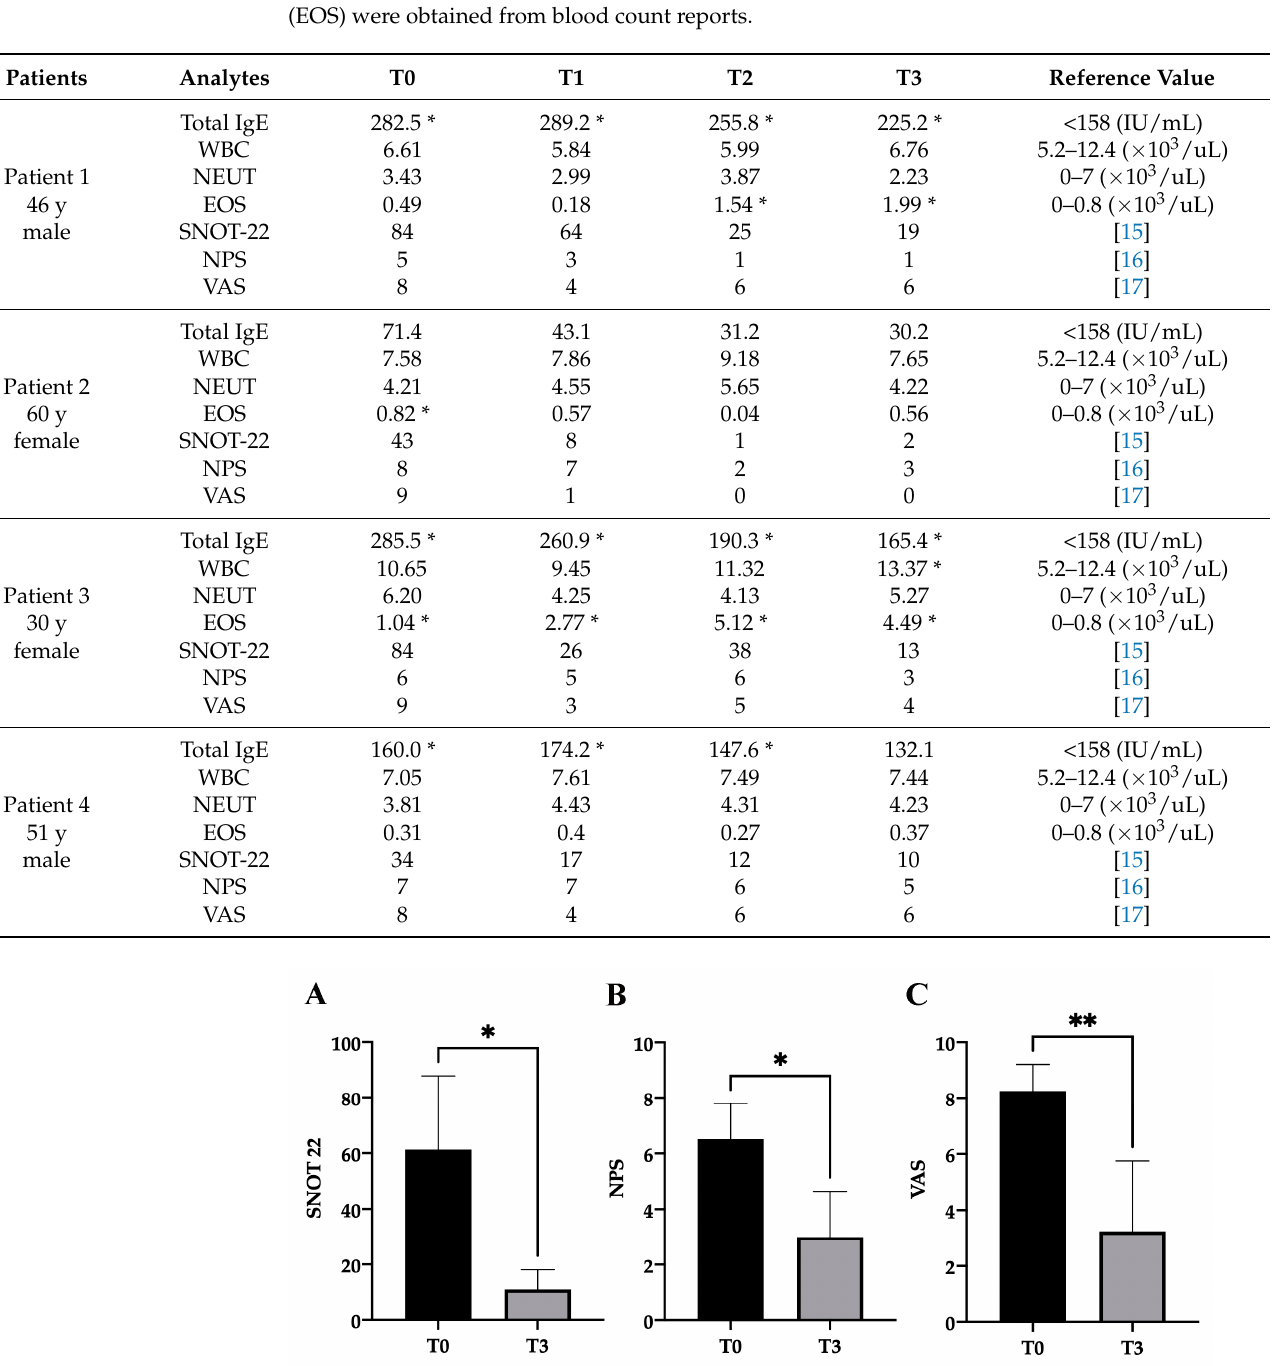
Figure 1. Clinical parameters pre (T0) and post (T3) treatment with Dupilumab. Patients were evaluated with regards to canonical diagnostic/prognostic scores, such as SNOT-22 (panel A ), NPS (panel B ), and VAS (panel C ). All parameters were expressed as means ± SD. Differences between two groups (T3 vs. T0) were analyzed by paired two-tailed t -test; * p < 0.05, ** p < 0.01. At the same time, we evaluated the variation of total IgE concentrations. We observed a significant reduction in serum IgE levels during the treatment (T1, T2, T3) in all patients (F = 7.51 and p = 0.008), which became more evident at the end of the treatment (T3) compared to baseline levels ( p < 0.05) (Figure 2A). Moreover, we observed